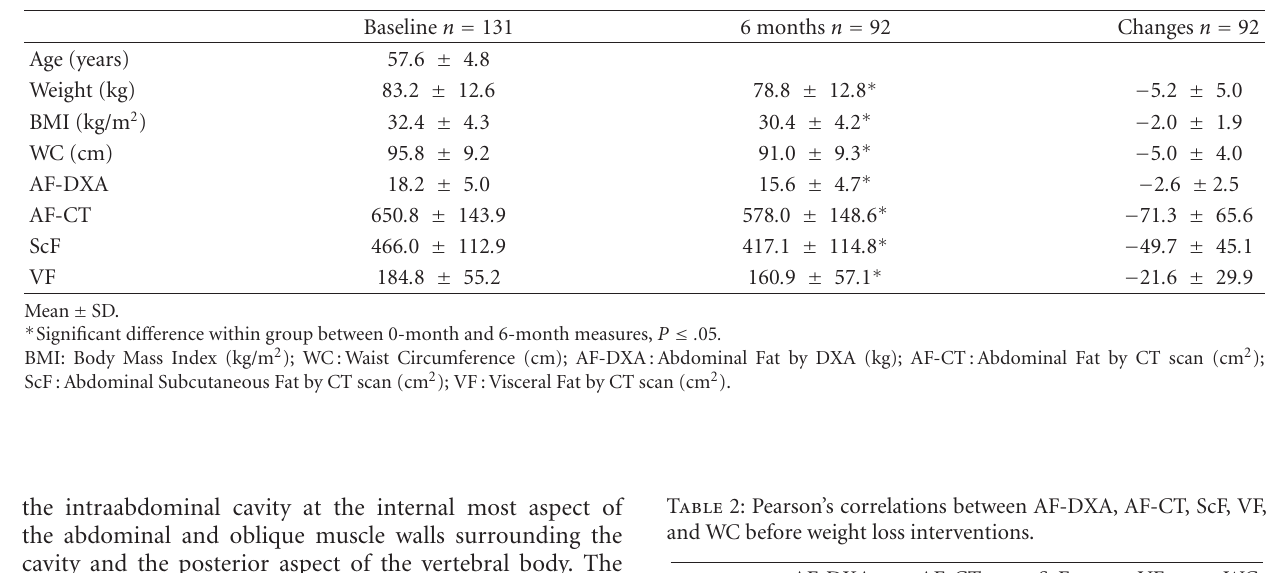
Table 1: Descriptive characteristics.